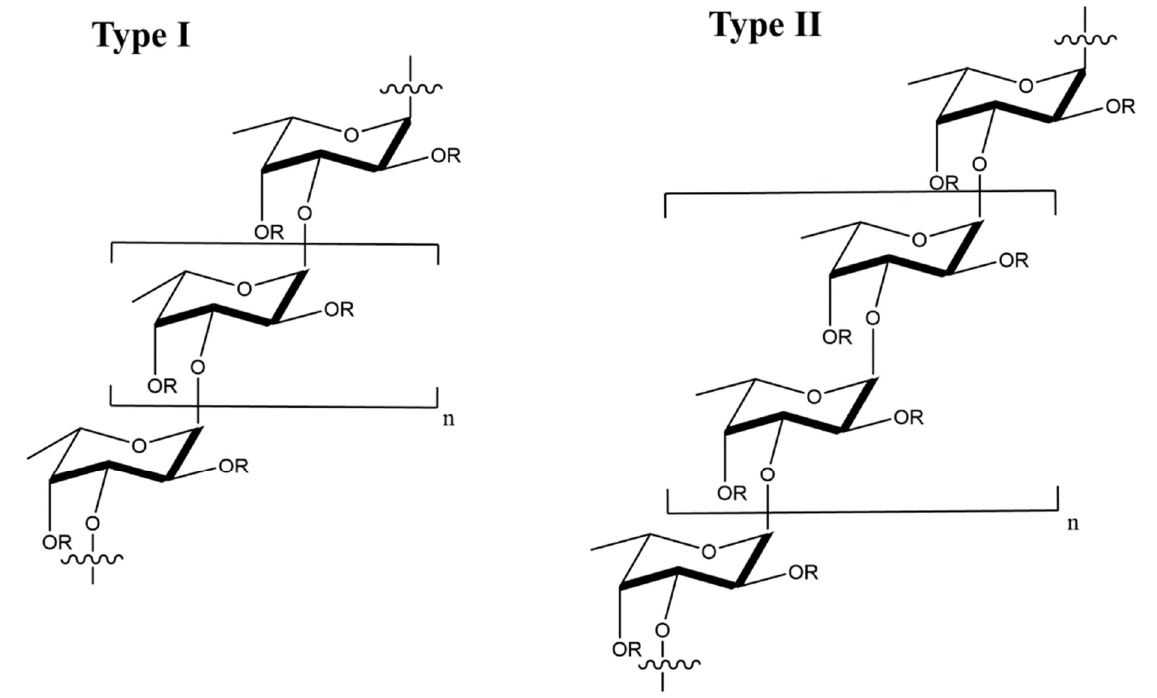
Figure 8. Molecular structure of type I and type II fucoidans from brown seaweed; the R groups represent sulfate, glucuronic acid, or fucopyranose